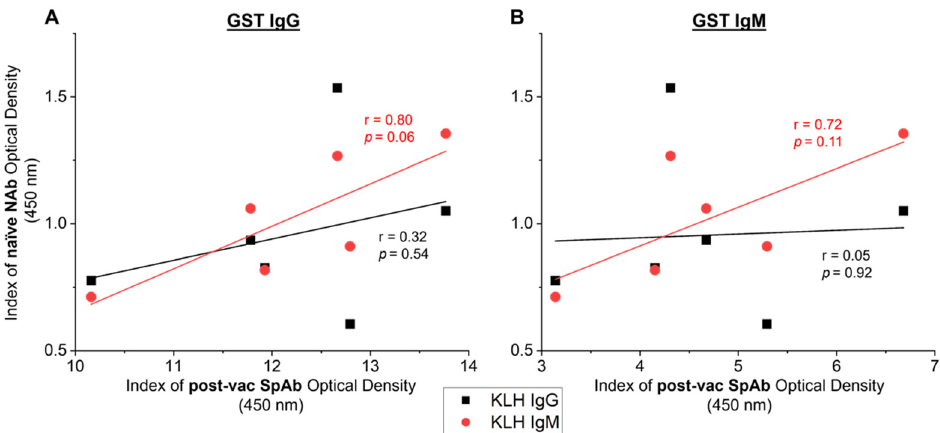
Figure 5. Relationship between specific antibodies (SpAbs) induced post-vaccination and the naïve natural antibodies (NAbs) in cows from study A ( n = 6). SpAb response towards native glutathione S -transferase (GST) IgG ( A ) and GST IgM ( B ) post-vaccination (post-vac) (day 42) were correlated to the naïve pre-vaccination (day 0) NAb response to IgG KLH (black squares) and IgM KLH (red circles). Linear regression lines are displayed for each SpAb and NAb relationship. Pearson’s correlation coefficients (r) and the corresponding significance value are noted on the graph next to the regression line. Results are reported as the mean index ( n = 4) of optical density (450